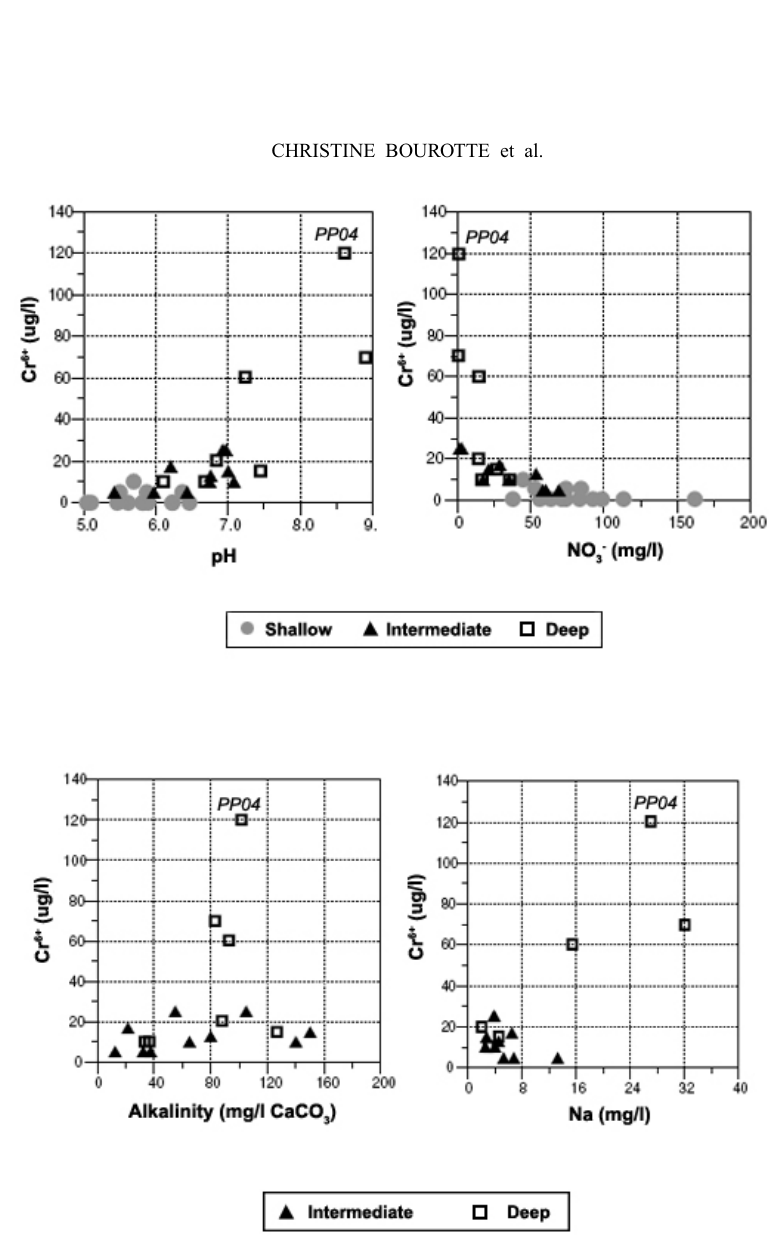
Fig. 5 – Relationship between hexavalent chromium concentrations and pH, nitrate, alkalinity and sodium